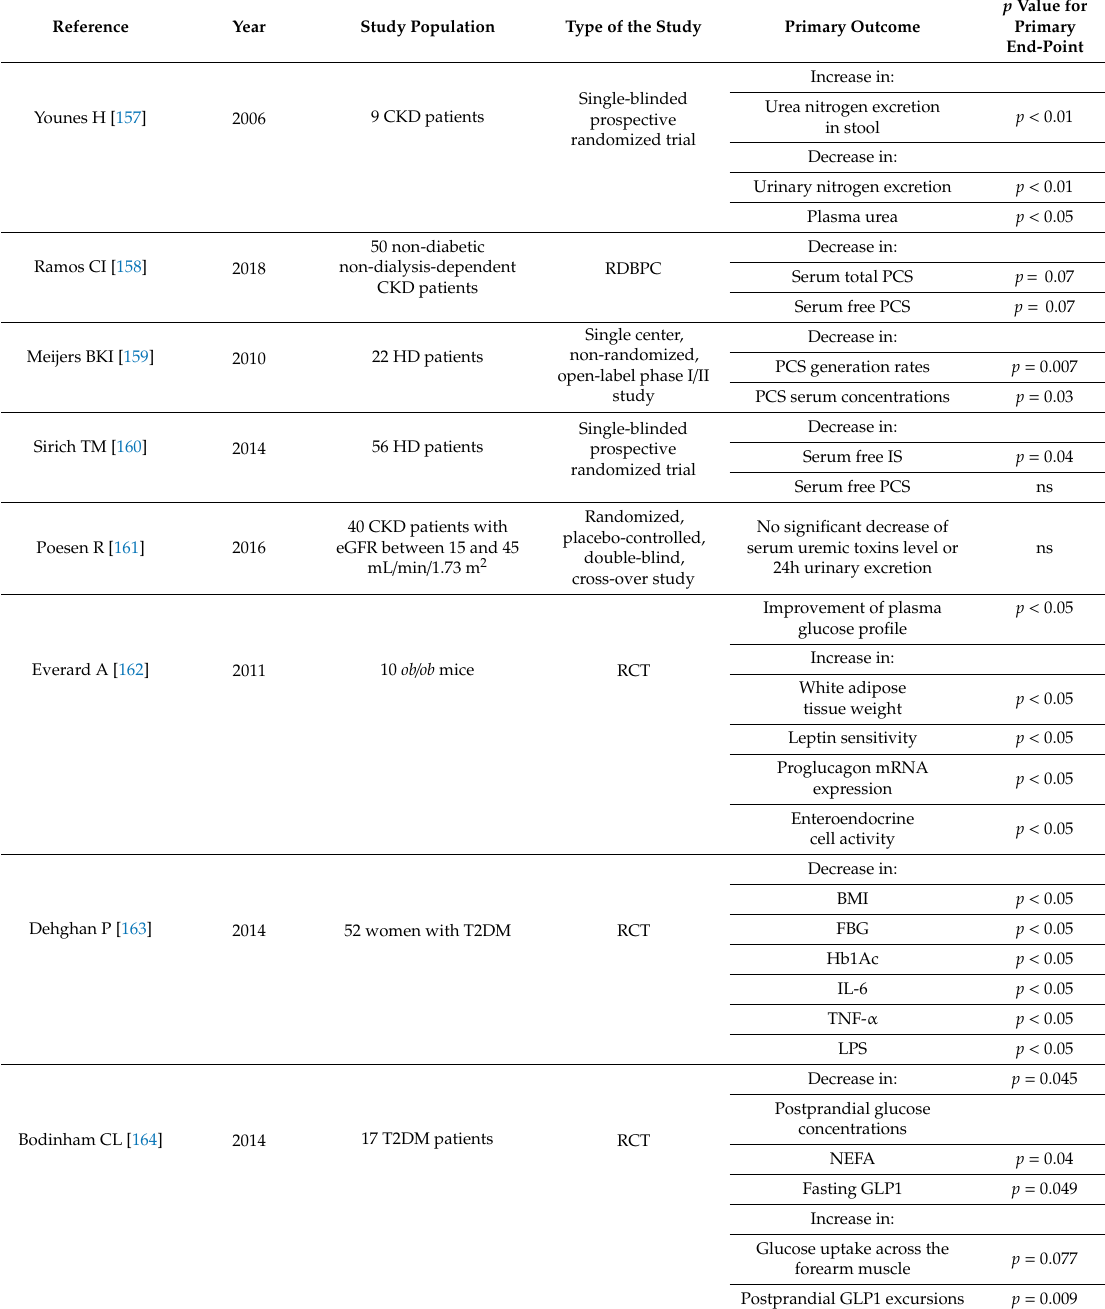
Table 2. Prebiotics e ff ects on CKD, DM and